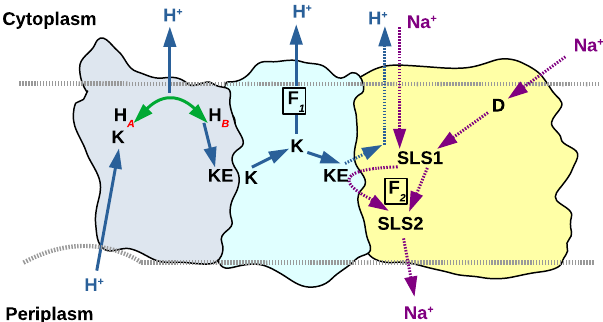
Fig. 7 | Proposed molecular mechanism of Mrp antiporter. Sodium ions reach the fi rst sodium-loading site (SLS1) at the strictly conserved and conformationally mobile Glu687 MrpA via a hydrated path involving conserved Asp38 MrpF (D) or alter- natively via a more direct but hydrophobic path observed in the structure and MD simulations (purple dotted vertical arrow). In MrpA (light grey-blue, left), proton transferoccursfrom the periplasm to conserved Lys353 MrpA (K).His248 MrpA accepts theprotonfromLys353 MrpA anddeliversittotheconservedLys/GlupairoftheMrpA subunit by a histidine switch supported by our cryoEM and MD simulation data (conformationalmobilityofHis248 MrpA isshownbyagreenlineandtwoalternative conformations H A and H B ). Transfer of a second proton to His248 MrpA (via Lys353 MrpA ) pushes the protonon the Lys/Glu pair of MrpA to Lys/Glu pairofMrpD (cyan) by electrostatic interactions. The second proton moves energetically downhill from His248 MrpA to the cytoplasm. Binding of the fi rst proton to the Lys/ Glu pair of MrpD drives the transfer of sodium bound at SLS1 (or at Glu137 MrpD ) to thesecondsodium-loadingsite(SLS2),whichcorrespondstothestrictlyconserved Glu780 MrpA , resulting in sodium release on the periplasmic side. The proton moves tothecytoplasmeitherviaMrpD(viathePhe-gatedroute,markedasF 1 )orthrough the hydrophobic pathway (blue dotted vertical arrow). Our model supports elec- trogenic antiportwith a stoichiometry of 2H + per Na + driven by the insidenegative membrane potential. Importantly, the Lys/Glu pair of MrpD is only ~10Å from Glu780 MrpA (SLS2), which would result in strong electrostatic coupling. Since there are several acidic residues that can bind sodium ions, it is also possible that cooperativesodiumbindingplaysaroleinsodiumtranslocation.Proposedproton transfer paths are shown as blue bold arrows (dotted for alternative routes) and sodium translocation paths as magenta arrows. The proposed Phe41 MrpB gate is marked as F 2